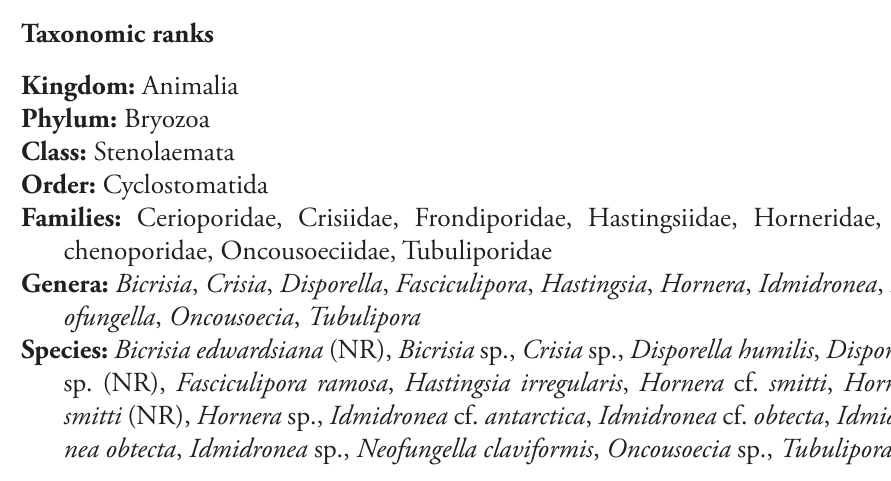
Taxonomic ranks Kingdom: Animalia Phylum: